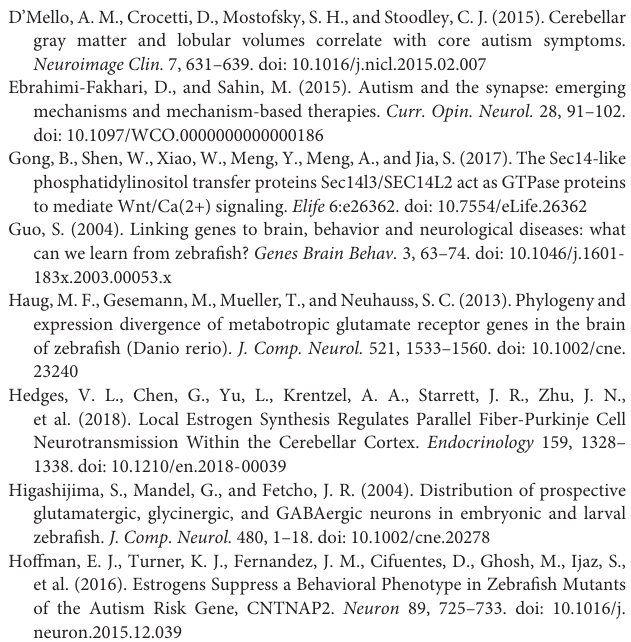
Supplementary Figure 7 | The quantification of the plasma/cytosol intensity in the in vivo PIP2 imaging by ImageJ. (A) The live fluorescence imaging of Tg( hsp70:plc-ph-mCherry ) with the confocal microscope. Scale bar = 10 µ m. (B) The outline of the selected cell was drawn manually. The mean fluorescent intensity was calculated by ImageJ, which is the mean fluorescent intensity of the whole cell (Area = 0.546, Mean value = 44.025). Scale bar = 2 µ m. (C) The cytosol fluorescent intensity was calculated after the outline of the cytoplasm was sketched (Area = 0.355, Mean value = 33.500). The plasma fluorescent intensity was obtained by subtracting cytosol intensity from whole cell intensity: The plasma fluorescent intensity = (mean fluorescent intensity of whole cell ∗ area of whole cell - mean fluorescent intensity of cytosol ∗ area of cytosol)/(area of whole cell - area of cytosol). The plasma/cytosol intensity = mean fluorescent intensity of plasma/mean fluorescent intensity of cytosol. Scale bar = 2 µ